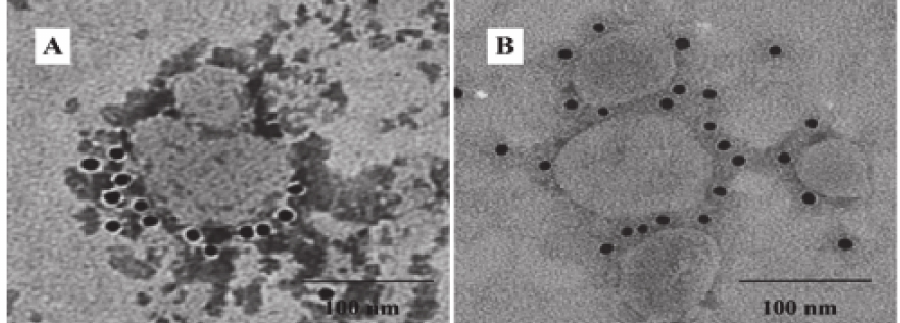
Figure 5. Analysis of the presence of S protein in the IBV VLPs by immunoelectron microscopy (IEM). ( A ) Purified